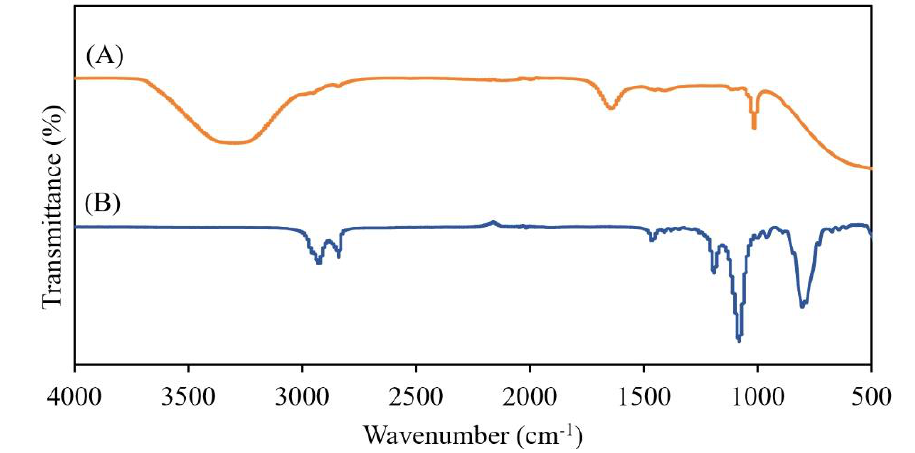
Figure 3. FTIR spectra of 1:3 molar composition of HTMS sol-gel coating (A) and raw HTMS (B).